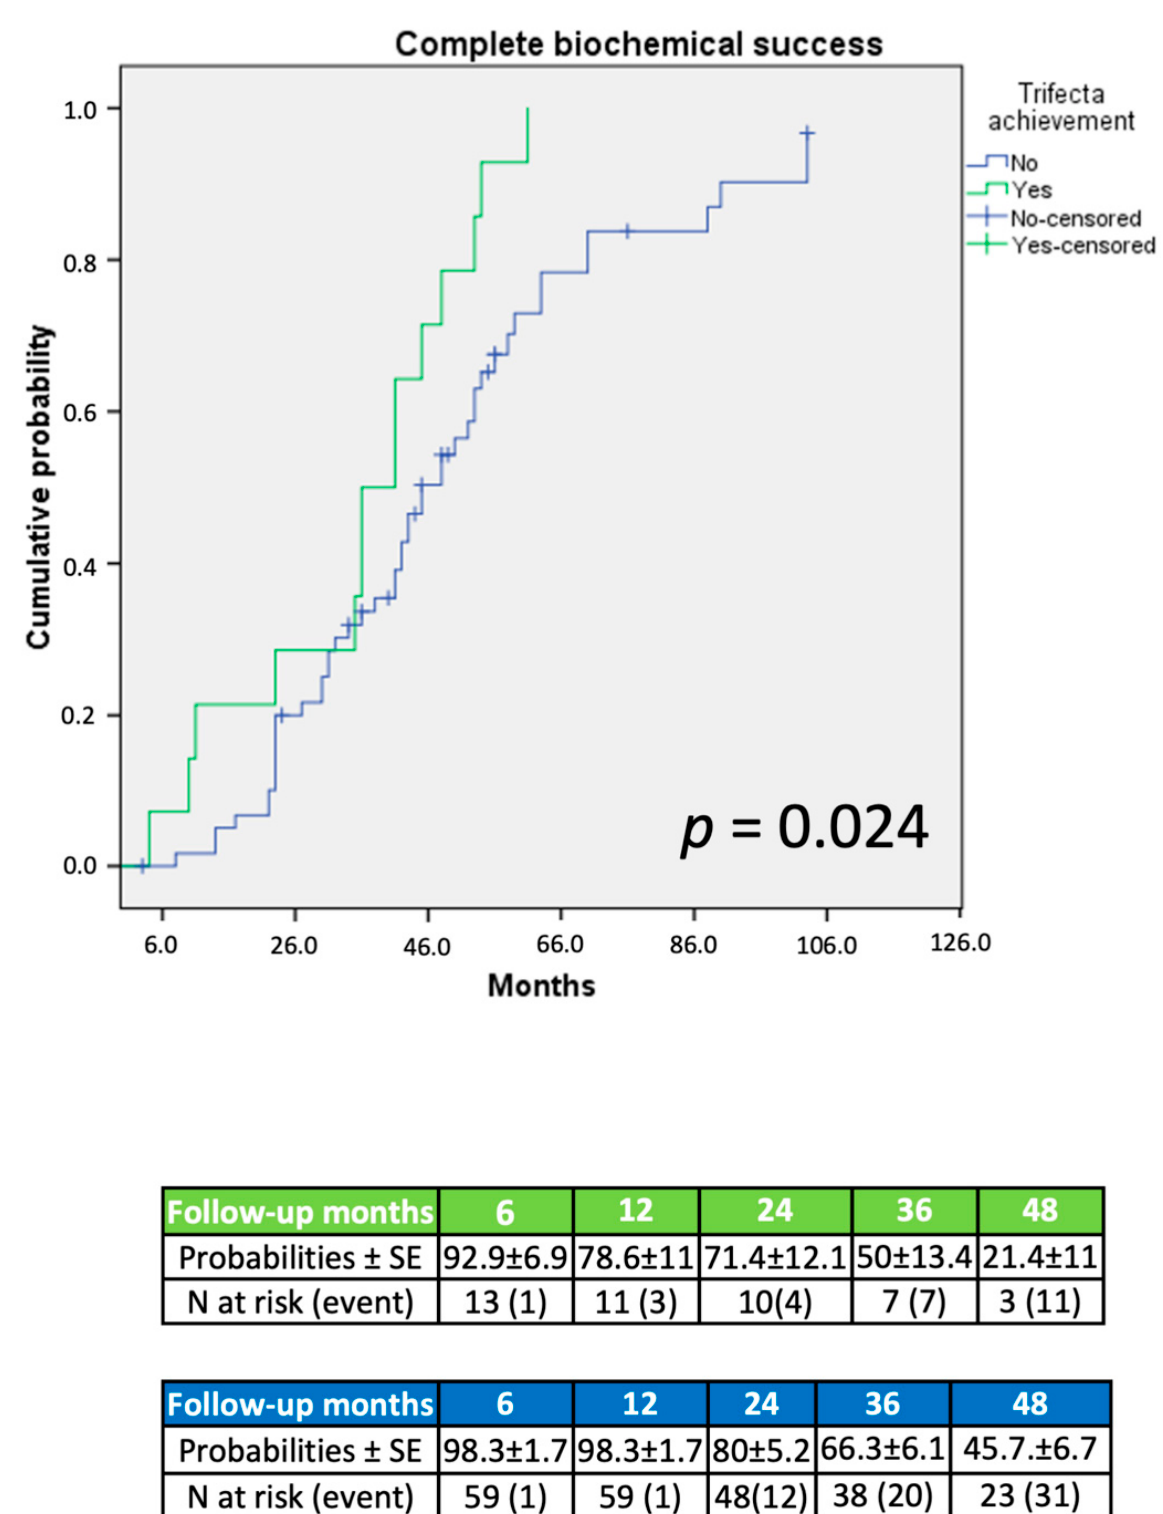
Figure 2. Probability of complete biochemical success according to PASO criteria.